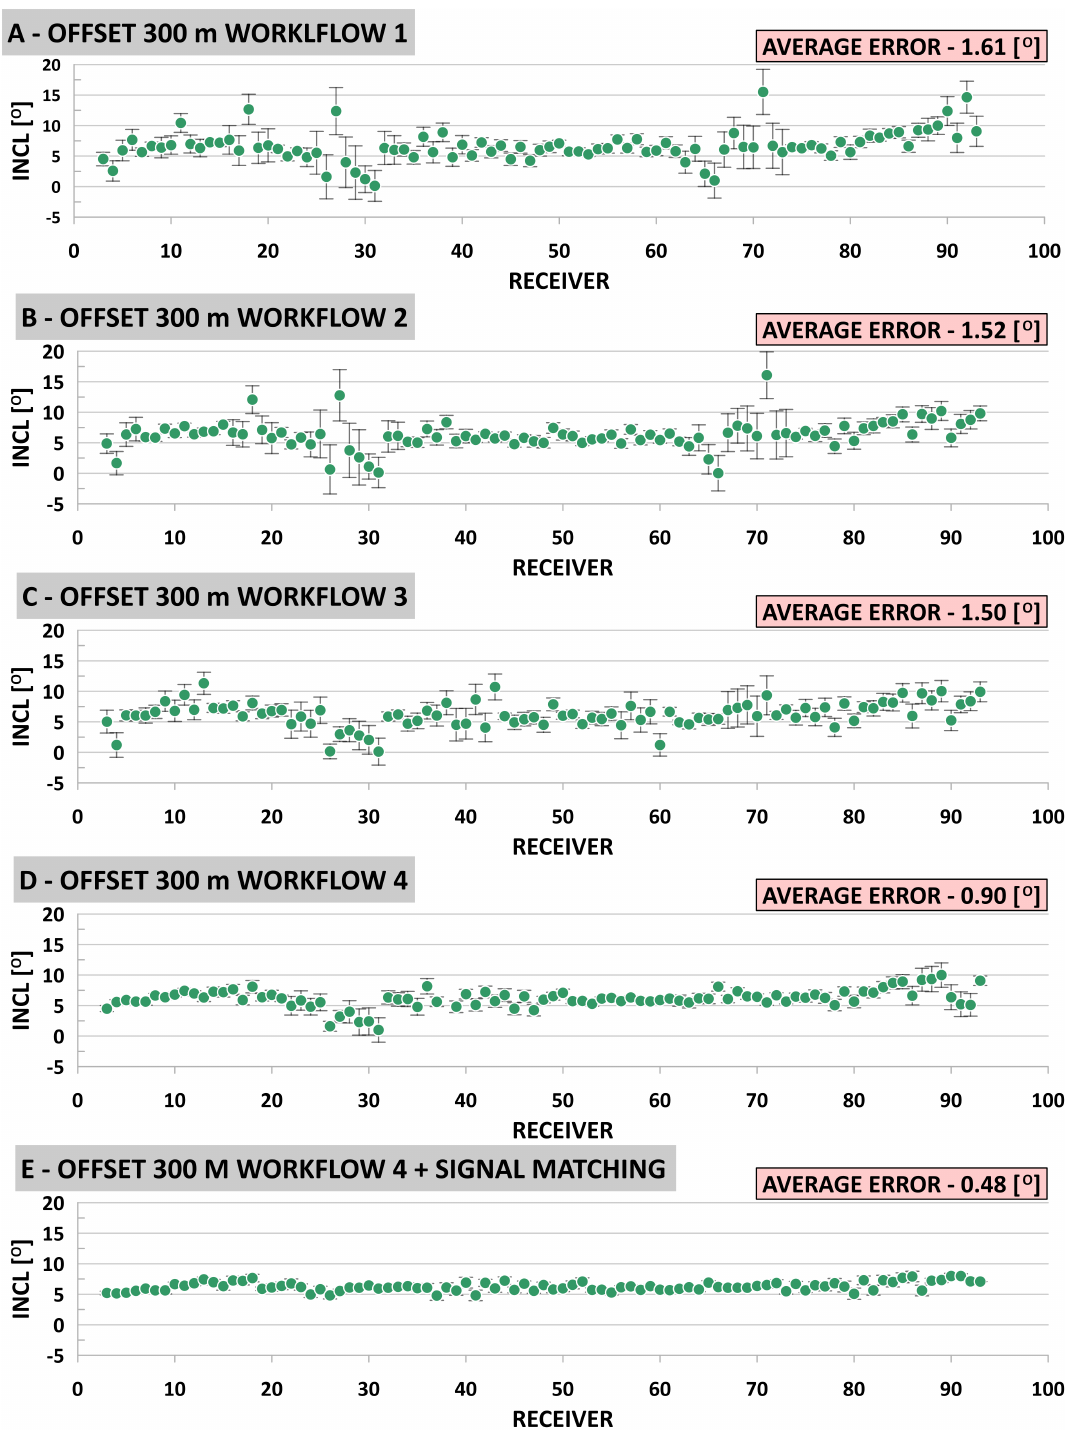
Figure 8. P-wave polarization angles (green dots) with error bars for different workflow schemes for the near-offset shot point (300 m): A is for W1, B for W2, C for W3, D for W4, and E is for W4 with signal-matching procedure